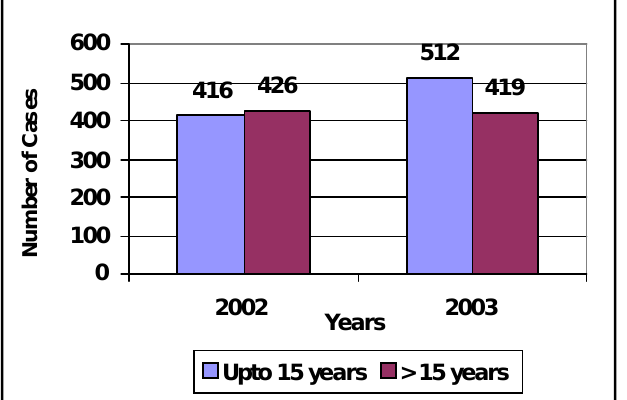
Fig. 7 : JE Cases: Cummulative Gender Distribution,